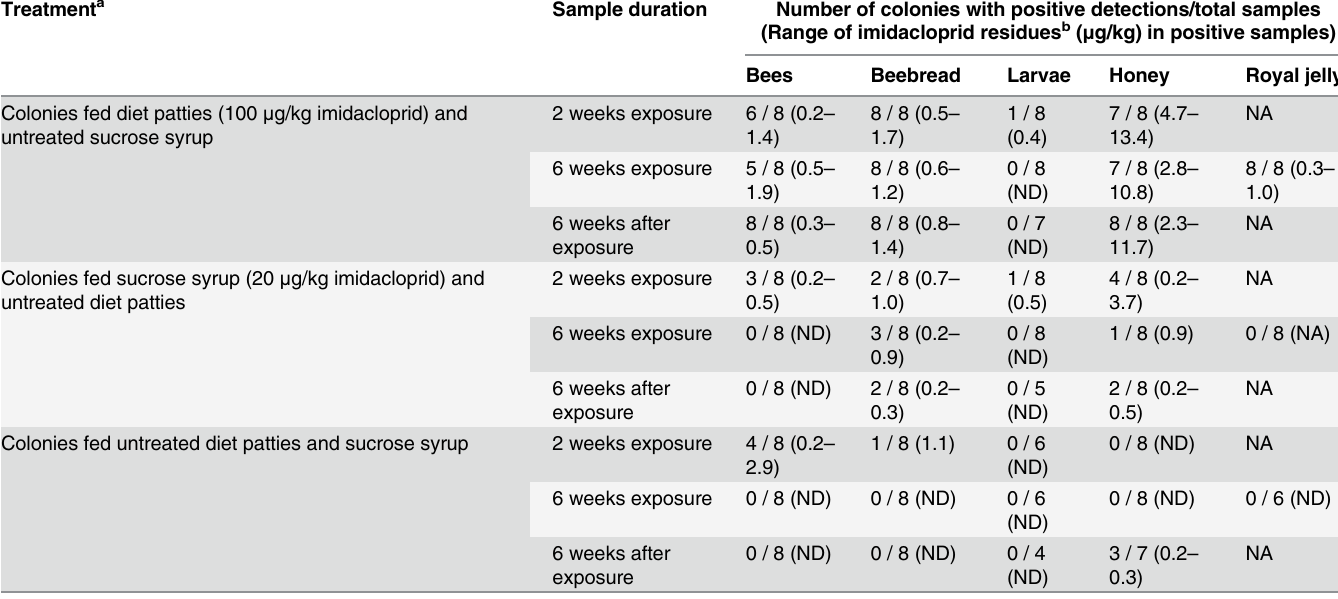
Table 1. Residues of imidacloprid in hive matrices resulting from feeding spiked Mega-bee diet patties and sucrose syrup to honey bee colonies for six weeks. Treatment a Sample